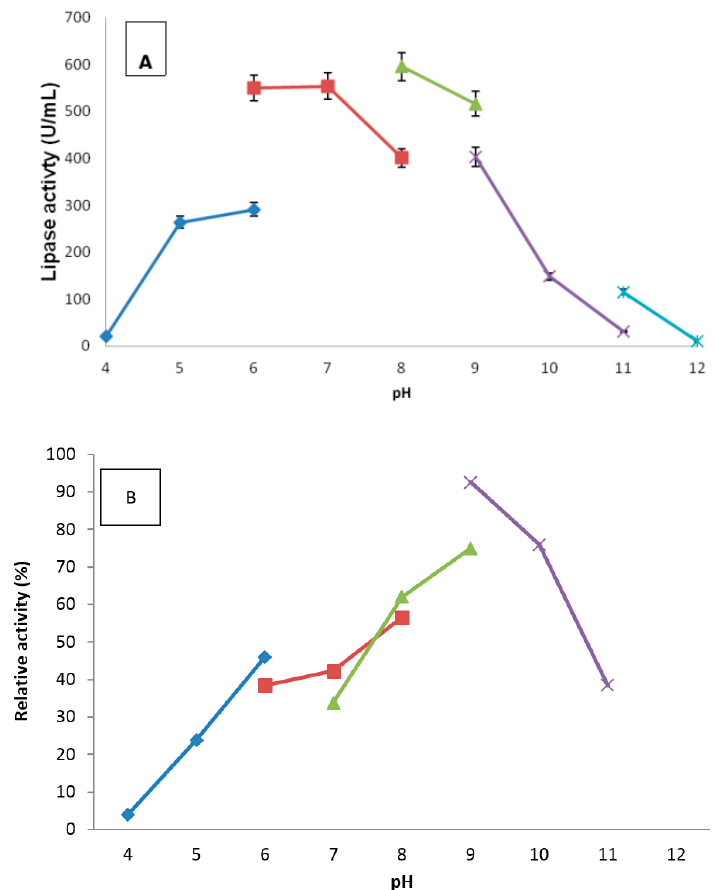
Figure 8. Effect of pH on purified truncated AMS3 lipase activity ( A ); The lipase activity was measured at different pH using olive oil emulsion as substrate. Effect of the pH on purified truncated AMS3 lipase stability is shown in ( B ). The enzyme was pre-incubated in different buffers for 30 min. Lipase assays were performed at 60 °C. Sodium acetate buffer was used for the pH range of 4.0 to 6.0 ( ♦ ); potassium phosphate buffer for the pH range of 6.0 to 8.0 ( ■ ); Tris-HCl buffer for the pH range of 8.0 to 9.0 ( ▲ ); and glycine-NaOH buffer for the pH range of 9.0 to 12.0 (x). Significant statistical differences according to ANOVA ( p < 0.05).